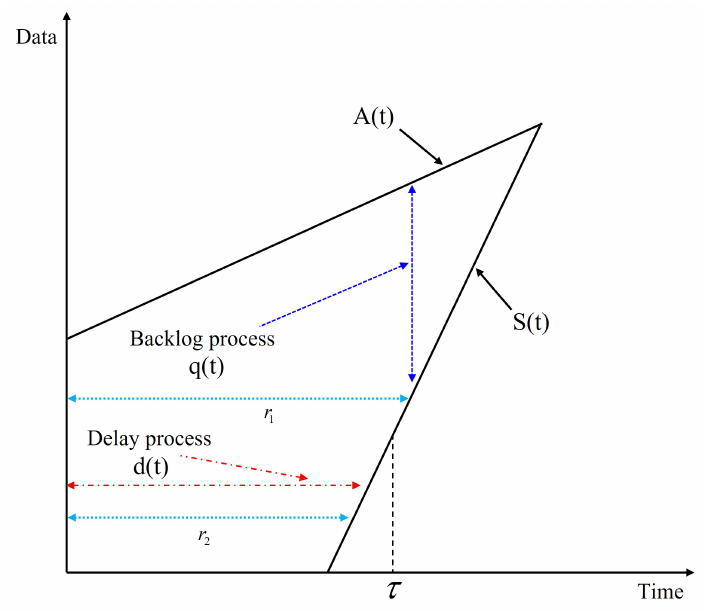
Figure 3. Representation of the backlog and delay